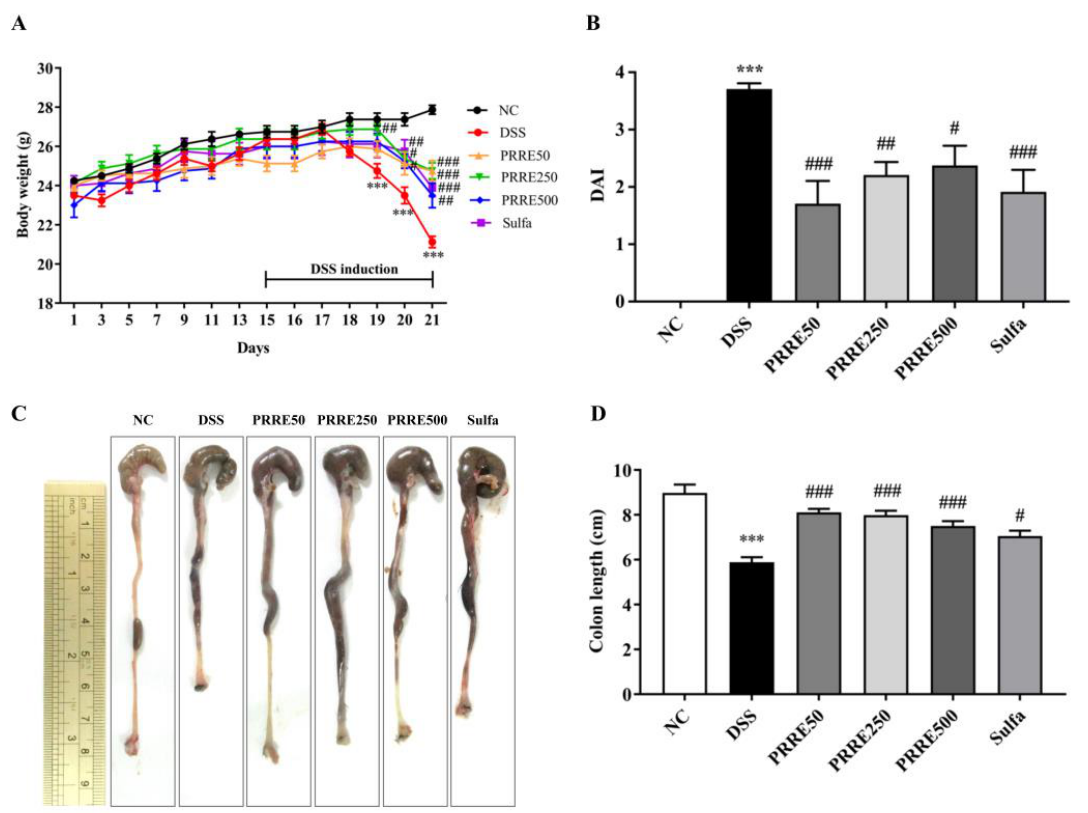
Figure 3. The effects of PRRE on clinical manifestations in DSS − induced colitis. The body weight of the animal ( A ), DAI scores ( B ), Gross appearances of the colon from each group ( C ) and Colon length ( D ). Data are expressed as mean ± SEM ( n = 8). *** p < 0.001 vs. NC group, # p < 0.05, ## p < 0.01 and ### p < 0.001 vs. DSS group. DSS = dextran sulfate sodium, DAI = disease activity index, NC = normal control mice treated with the vehicle, DSS = mice treated with DSS alone, PRRE50 = DSS mice treated with PRRE at 50 mg/kg/day, PRRE250 = DSS mice treated with PRRE at 250 mg/kg/day, PRRE500 = DSS mice treated with PRRE at 500 mg/kg/day and sulfa = DSS mice treated with sulfasalazine at 50 mg/kg/day.